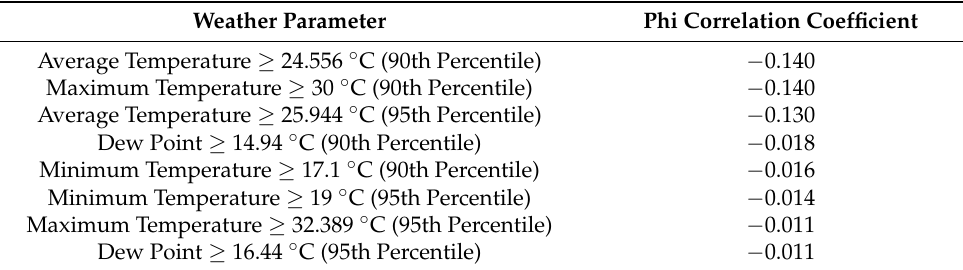
Table 5. Relationship between the extreme meteorological parameters and the number of COPD- related emergency visits per day, p < 0.05.